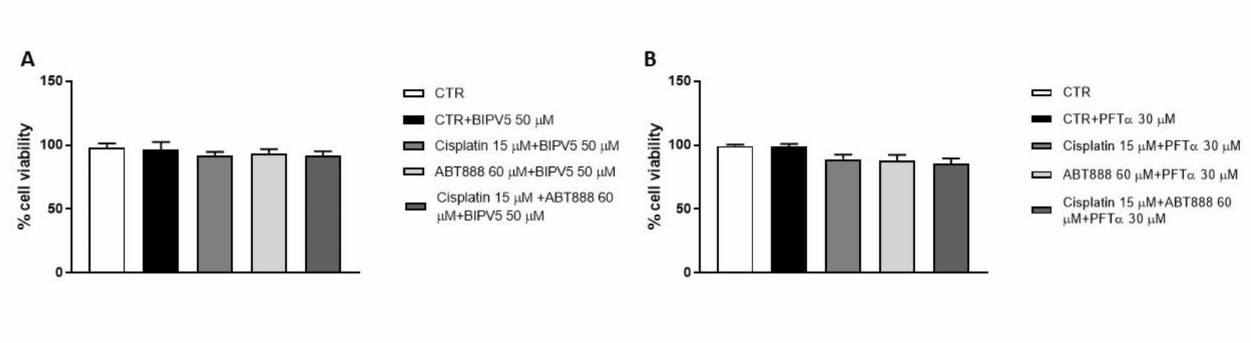
Figure 8. Effect of BIPV5 and PFT- α on CAL27 cell viability. MTT assay revealed that the apoptosis inhibitor BIPV5 and p53 inhibitor PFT- α did not reduce CAL27 cell viability in the control group as well as alone or in association with ABT888 and cisplatin, as shown in Figures A and B